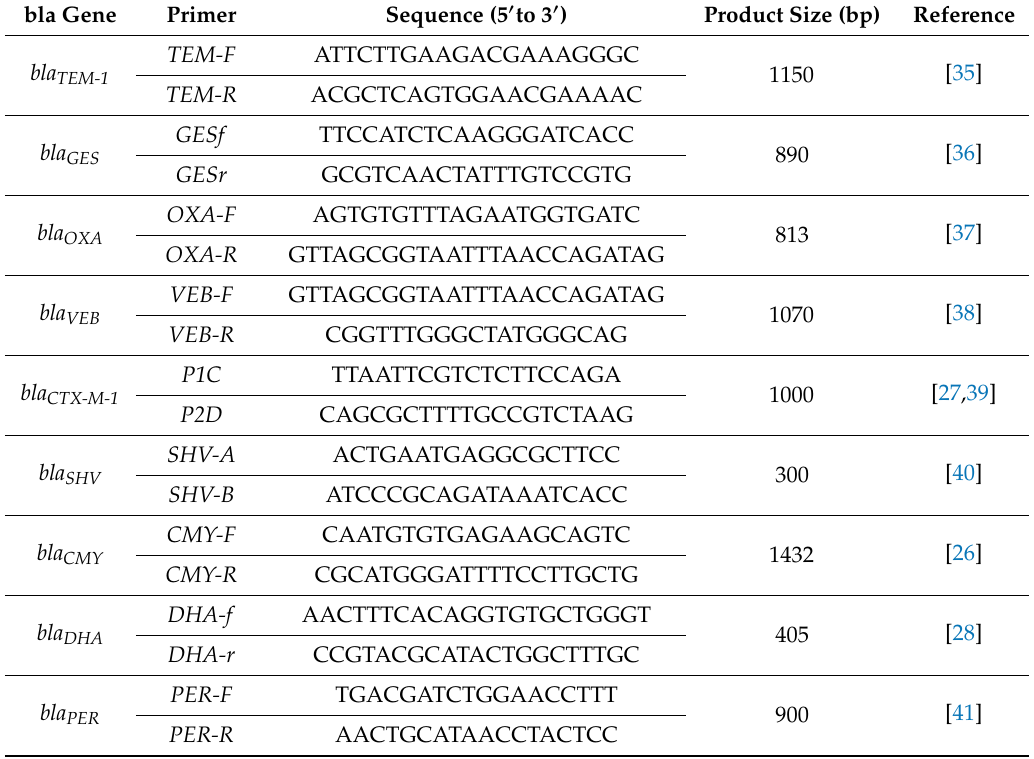
Table 1. Oligonucleotides used as primers for